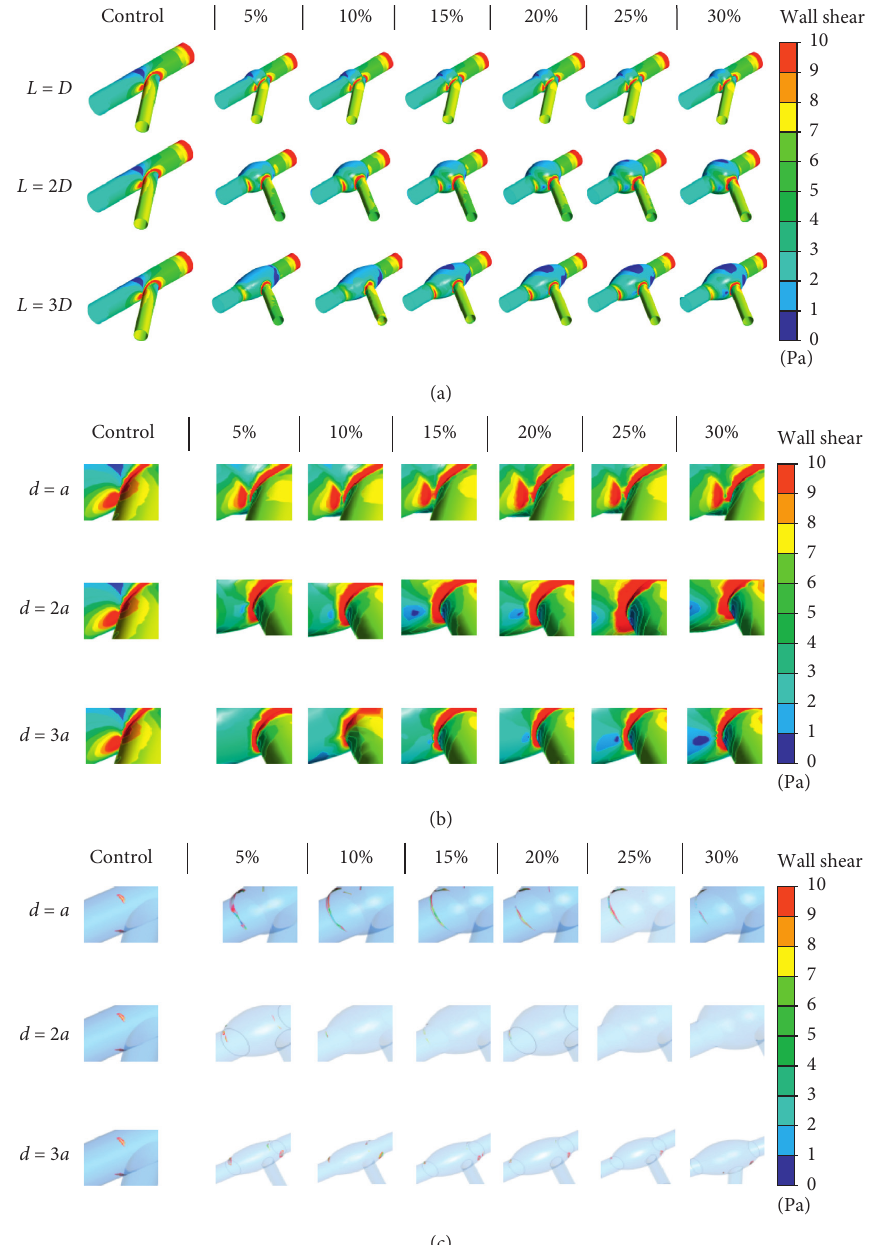
Figure 5: Wall shear stress distribution. (a) Wall shear stress distribution on the entire vessel. (b) Wall shear stress distribution at side branches and main walls. (c) Wall shear stress distribution on the side branches and main walls on isosurfaces at wall shear stress equals to